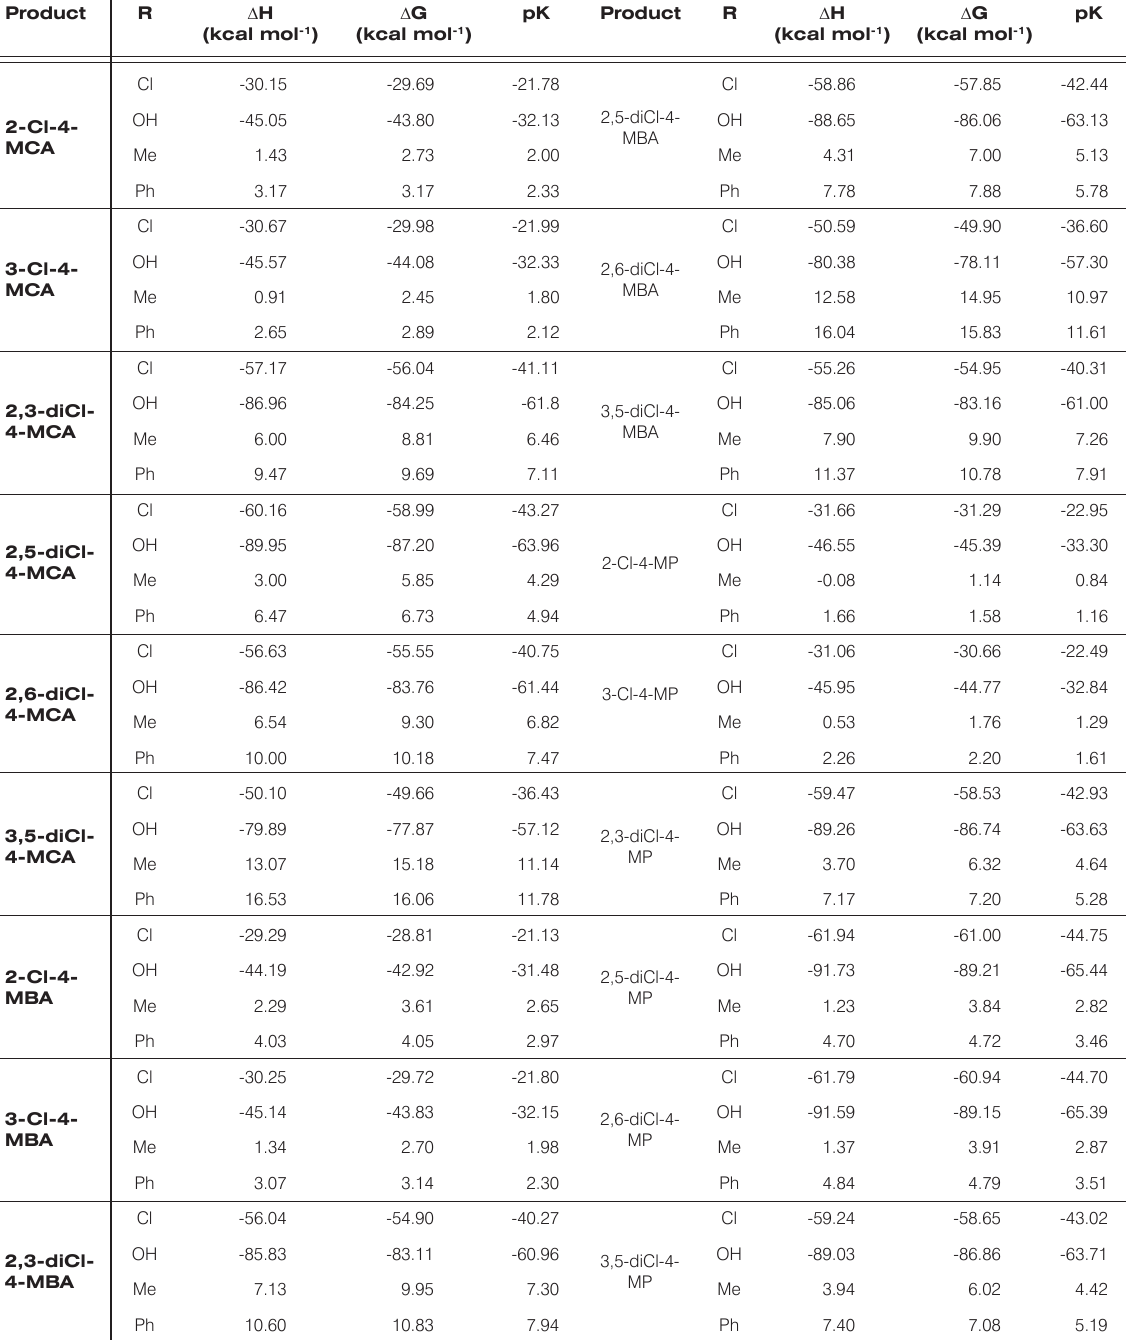
Table 3. Thermodynamic data calculated for monochlorination and dichlorination reactions shown in Fig. 6.